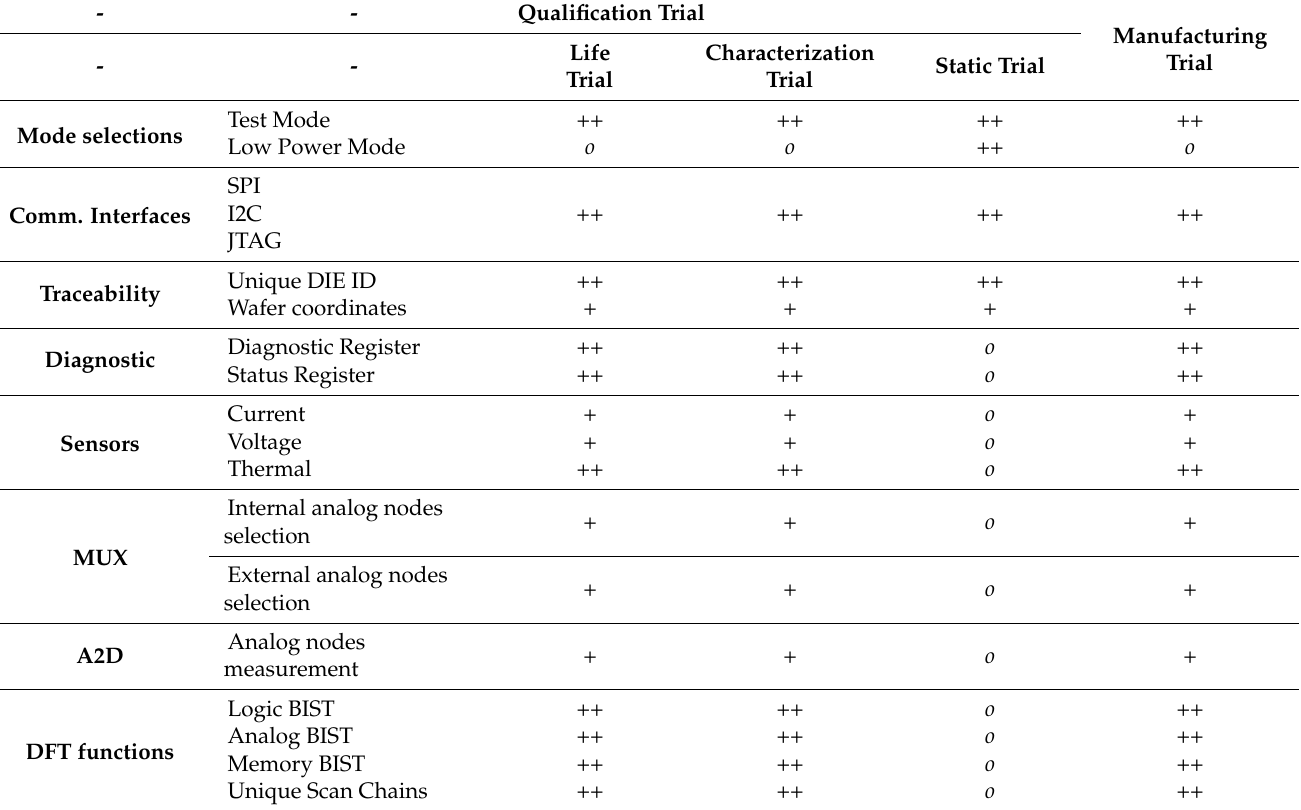
Table 1. Embedded circuitry and their relevance to different types of test.